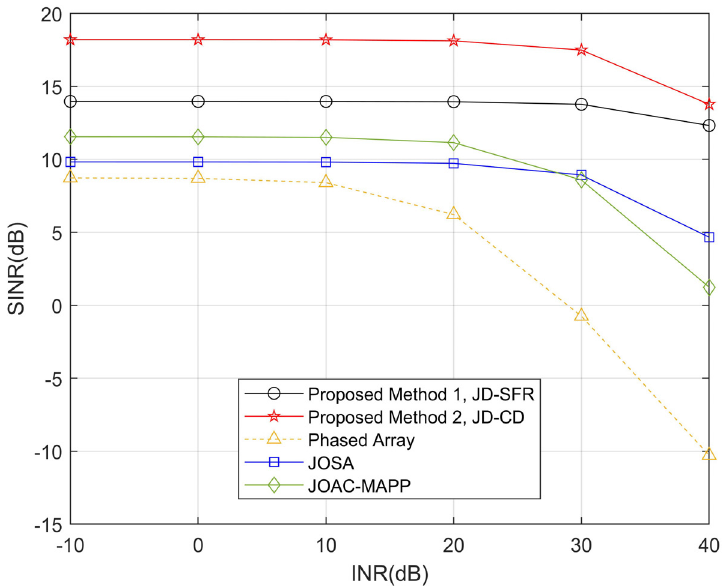
Figure 6. Compare the relationship between SINR loss and interference power obtained by the proposed method and other methods.